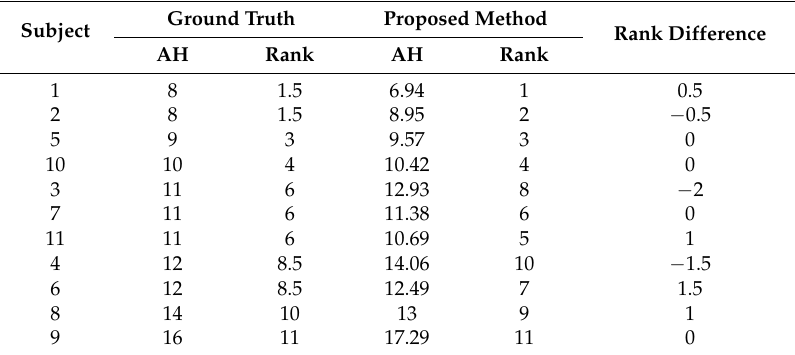
Table 4. Individual subject rankings based on AH.